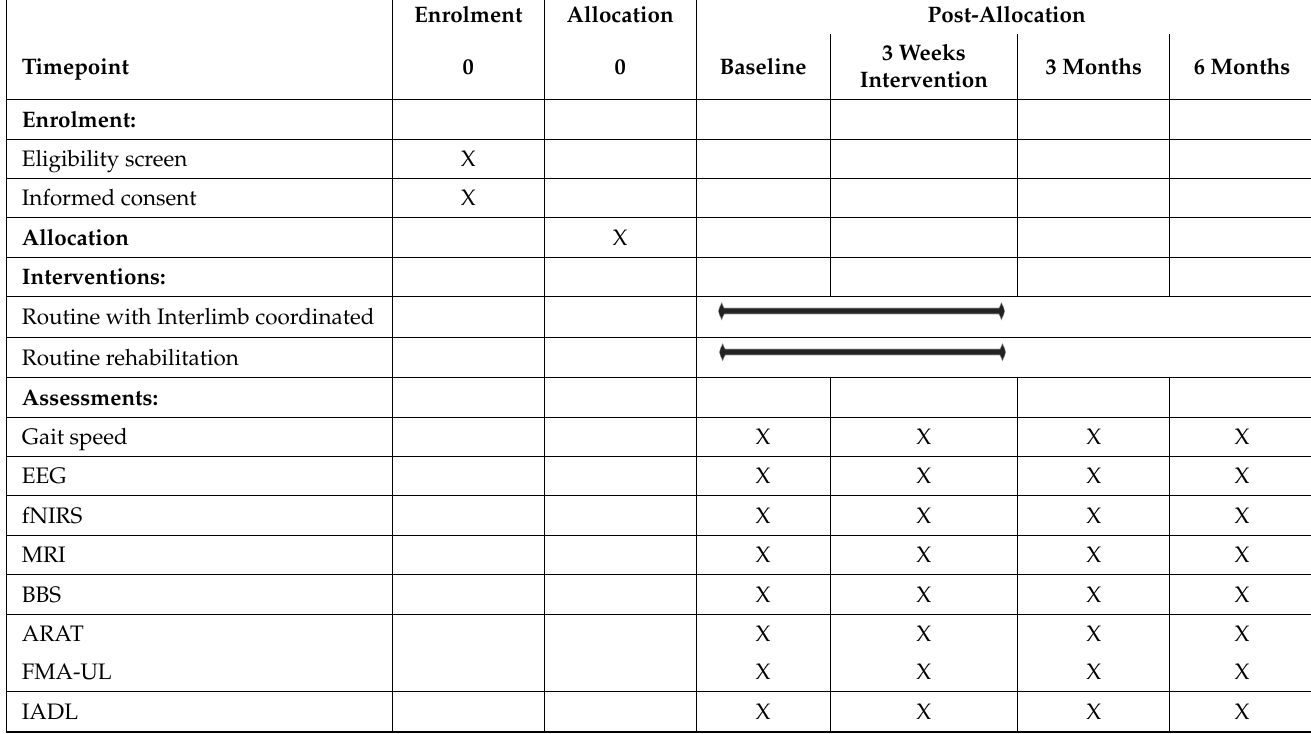
Table 2. SPIRIT diagram for the study.